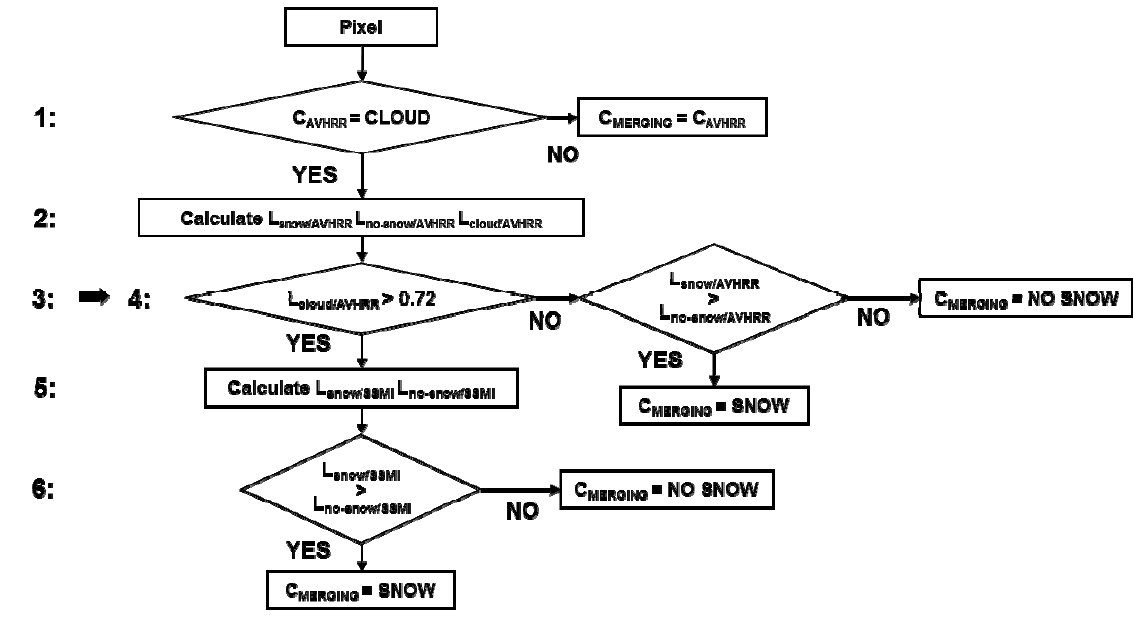
Figure 3. Flowchart of the decision process for merging AVHRR and SSM/I snow maps: C represents the pixel’s class according to the algorithm and L , the class’s ALGORITHM likelihood according to a given algorithm within a ±4 day window (Equation